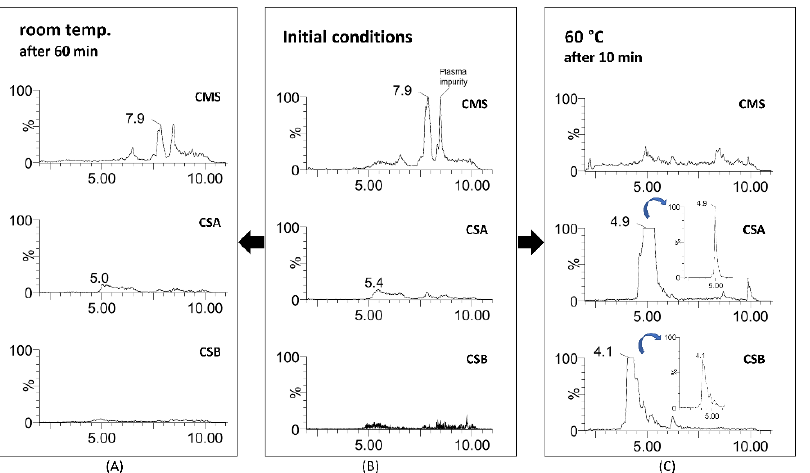
Figure 5. Detection of CMS, CSA, and CSB at initial conditions (room temperature) ( B ) and after hydrolysis with 0.5 M sulfuric acid at 20 °C after 60 min ( A ) and at 60 °C after 10 min ( C ) in plasma samples. CS peaks appeared at 70 °C (CSA at 4.9 min and CSB at 4.1 min) after the total hydrolysis of CMS. The y axis was kept the same in all figures except in the inserts, where it has been normalized. Performing the hydrolysis with sulfuric acid at 60 ◦ C, the results were different. After 10 min, no CMS remained and CS peaks were detected. CSA and CSB were eluted at 4.9 min and 4.1 min, respectively (Figure 5). The experiment was performed at the two aforementioned CMS concentrations: 20 µ g mL − 1 and 60 µ g mL − 1 . The ratio of